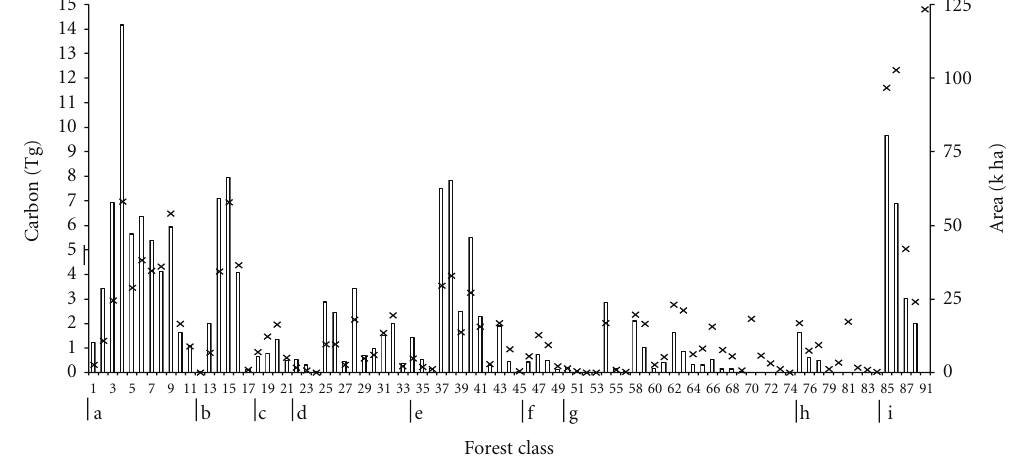
Figure 4: Areas and amount of carbon stored in standing trees in Forest Classes in Tasmanian State forest. Forest Classes, 57, 78, 89, and 90 are omitted. For a more complete description of Forest Classes refer to Table 1. Bars denote carbon, crosses denote area. a: mature eucalypt, b: mature eucalypt with unheighted regrowth, c: mature eucalypt with silvicultural regeneration, d: unaged eucalypt regrowth with mature eucalypt, e: pure unaged regrowth eucalypt, f: regrowth eucalypt with silvicultural regeneration, g: even aged eucalypt silvicultural regeneration, h: unstocked, and i: noneucalypt